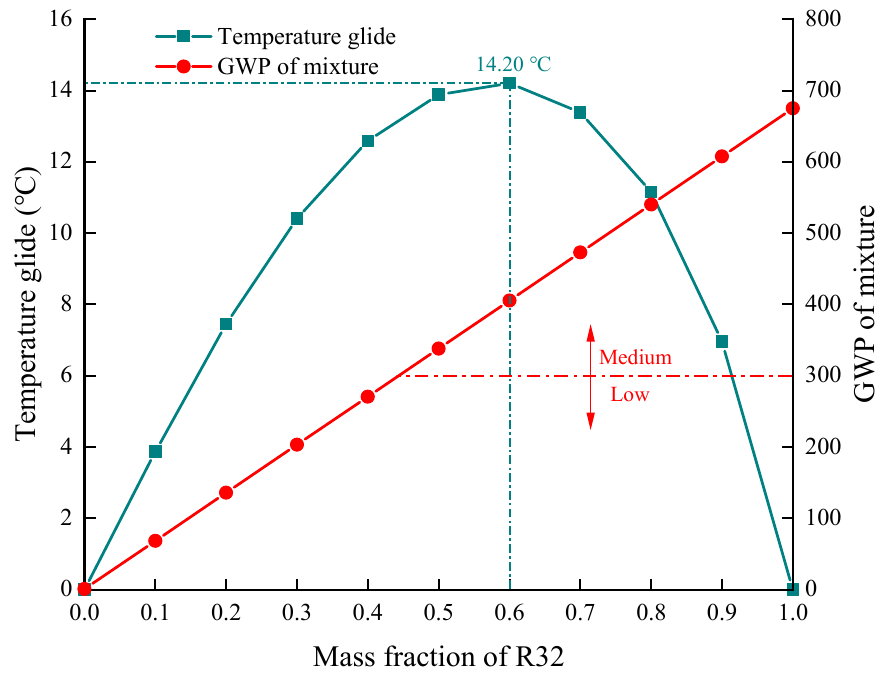
Figure 2. Temperature glide and GWP of the CO 2 -based mixture.